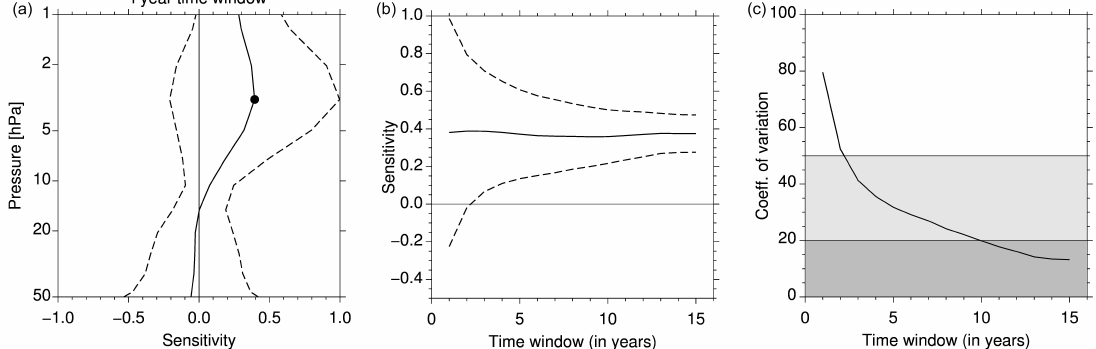
Figure 11. (a) CCM mean ozone sensitivity profile over the 1991–2005 period computed for a 1-year time window (see text for details on calculations). (b) Mean ozone sensitivity at 3hPa (dot in a ) as a function of the size of the time window. The dashed lines in (a, b) represent the 2 σ spread. (c) Coefficient of variation (in %) of the ozone sensitivity as a function of the size of the time window. Intervals with values lower than 50 and 20% are highlighted by the gray shaded